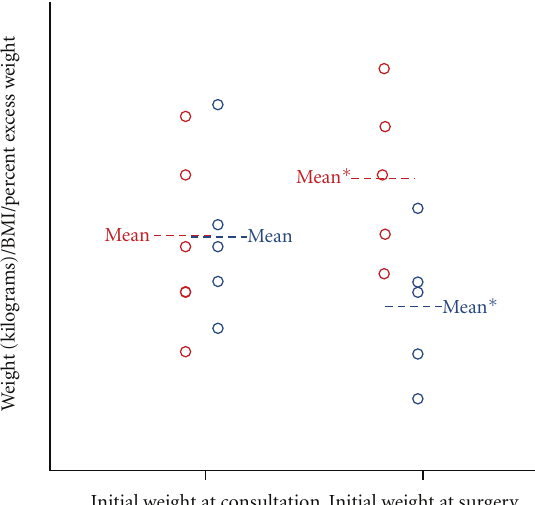
Figure 3: Example of class B study. Graph showing ten hypothetical patients in class B study who have been divided into weight loss (blue) and weight gain (red) groups. The weight loss group was statistically di ff erent from the weight gain group at initial consultation. ∗ Confidence interval